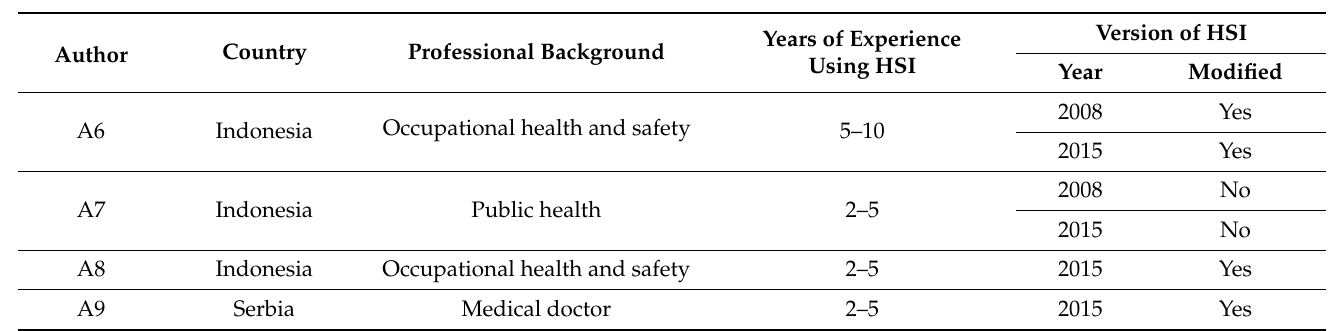
Table 1. Overview of the demographics of the participants.